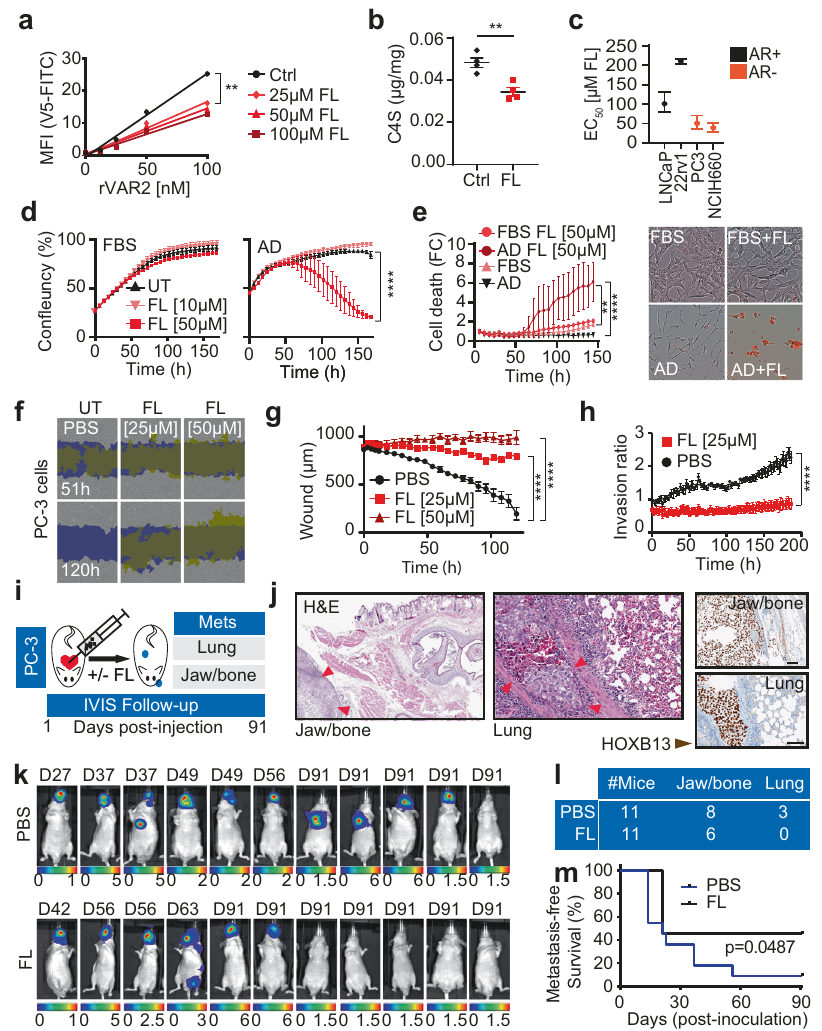
Fig. 6 | Chondroitin sulfate enables cell motility and metastases in castration- resistant prostate cancer. a CSA measurements in LNCaP cells after 72h of Fluorosamine (FL) treatment using rVAR2 binding on fl ow cytometry; linear regression followed by Ancova test; p <0.0001, F =18.59, DFn=3, DFd=12. b LC- MS quanti fi cation of C4S in LNCaP cells in AD condition after 72h of FL treatment (50 μ M). Data are shown as mean±SEM; n =4 biological replicates; p =0.0041 by two-tailed t test. c FL EC50 values in AR+and AR- PC cell lines. Data are shown as EC50plusupperandlowerlimits; n =8biologicalreplicates. d Growth(IncuCyte)of LNCaP cells in FBS or AD conditions±FL treatments. Data are shown as mean± SEM, n =4biologicallyindependentcellcultures;after100h p <0.0001bytwo-way ANOVA followed by Tukey ’ s test. e Cell death measurement of LNCaP cells treated asin d usingpropidiumiodide(redstaining;Incucyte)(Leftpanel).Dataareshown asmean±SEM, n =4independentsamples;after100h p <0.05bytwo-wayANOVA followed by Tukey ’ s test. Representative image of Incucyte at endpoint (Right panel) f Representative images of wound healing closure in PC3 exposed to FL